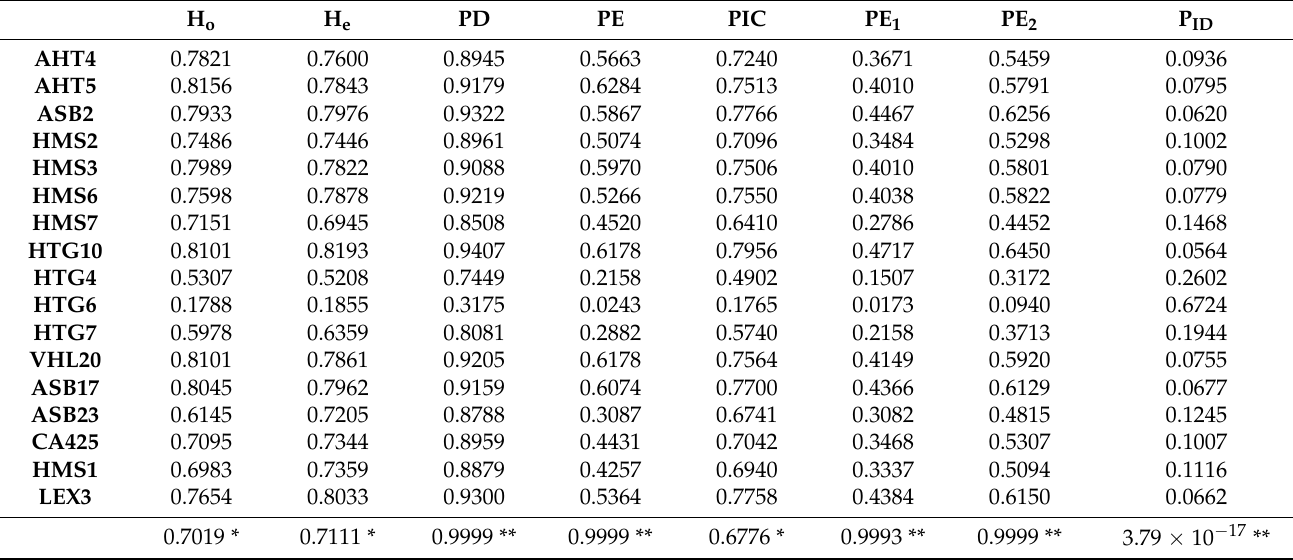
Table 2. Population coefficients of the 17 microsatellite markers (STR